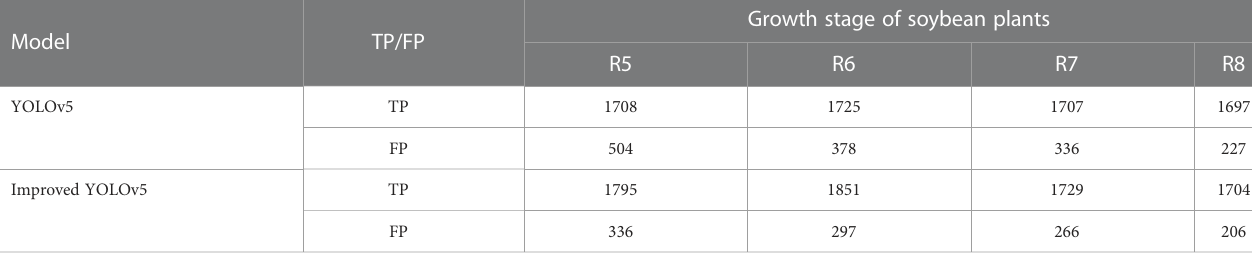
TABLE 2 Comparison of TP and FP between YOLOv5 model and improved YOLOv5model.